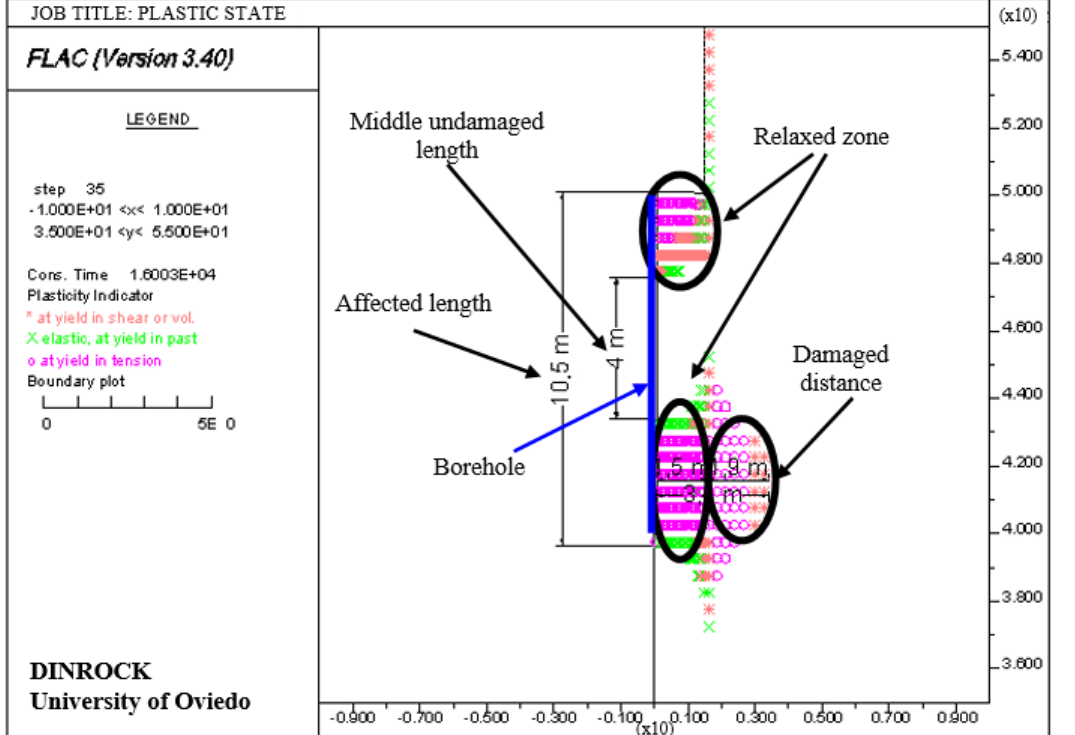
Figure 10. Plastic state for injection in model 2.